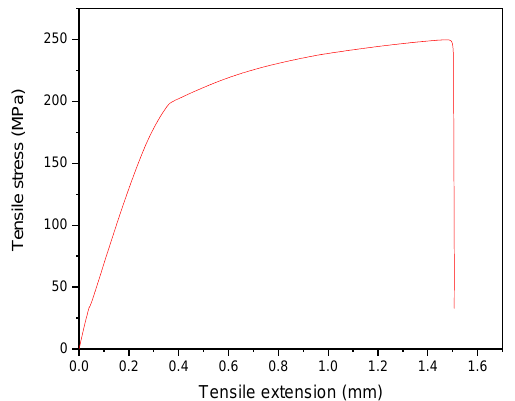
Figure 9. Hybrid composite optimal results.